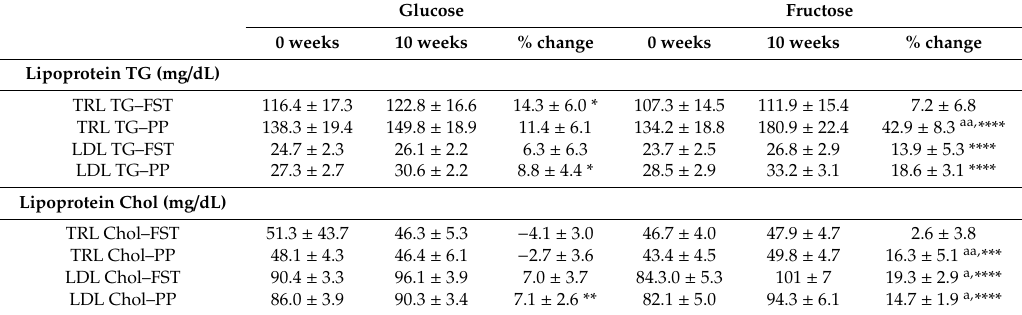
Table 2. Total fasting (FST) and postprandial (PP) TG and cholesterol concentrations in TRL and LDL fractions before and after consumption of glucose ‐ and fructose ‐ sweetened beverages for 10 weeks. Glucose Fructose 0 weeks 10 weeks % change